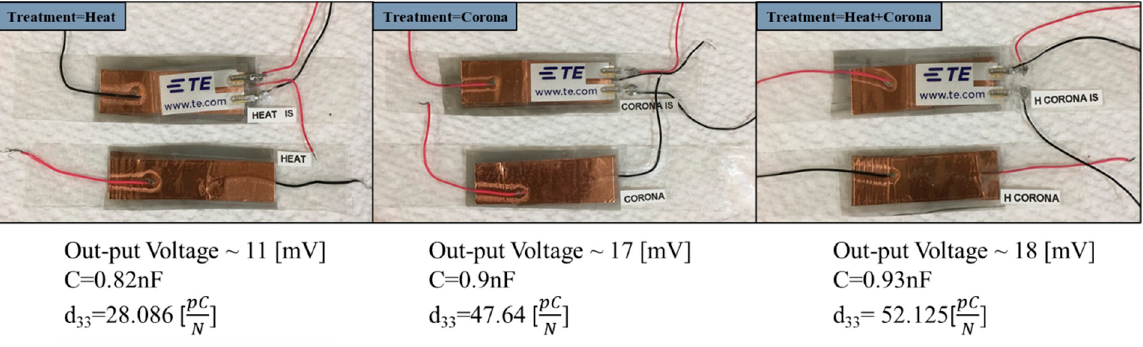
Figure 10. Piezoelectric Coefficient (d 33 ) of three different samples.